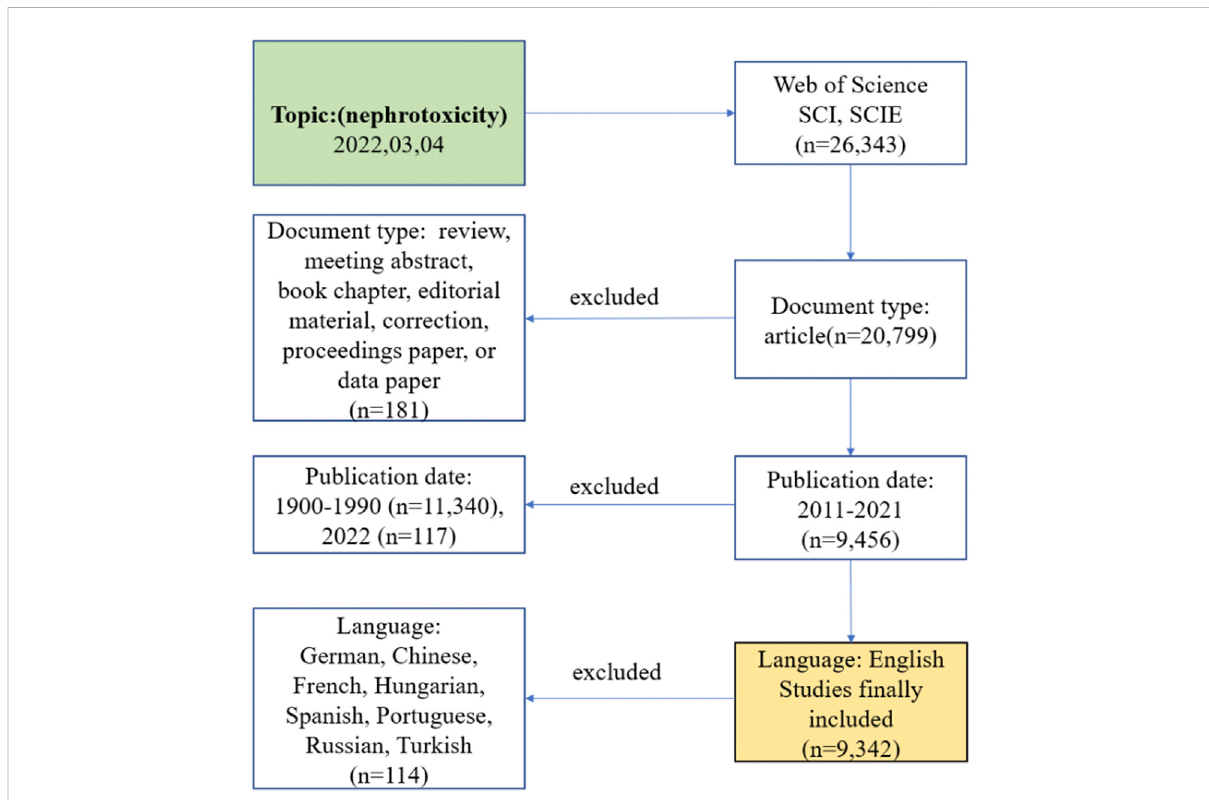
FIGURE 1 Frame fl ow diagram of nephrotoxicity search strategy from 2011 to 2021 based on Web of